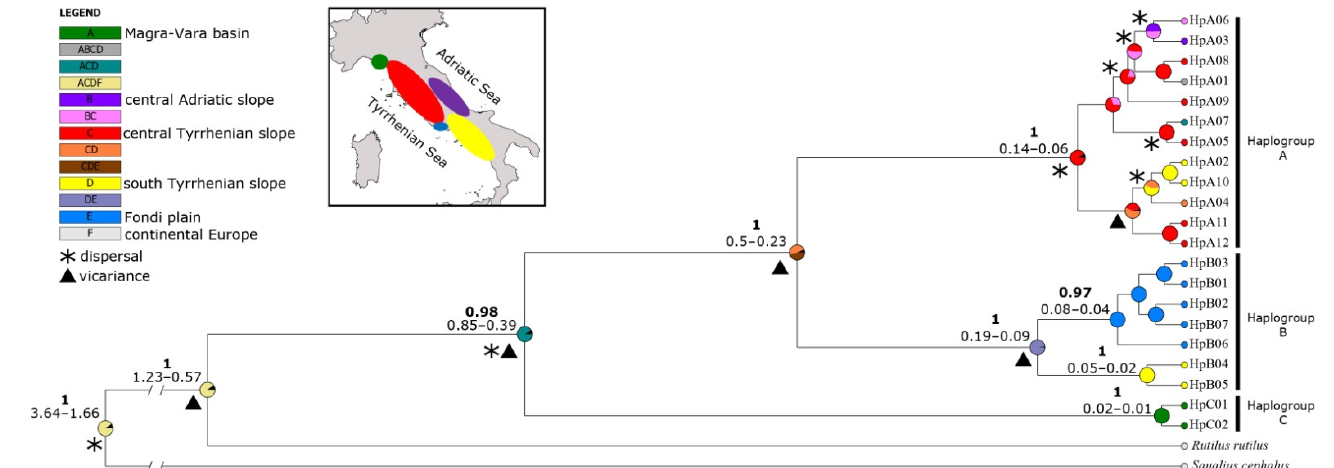
Figure 5. Bayesian CR tree with time estimates at supported nodes and ancestral area reconstruction of Sarmarutilus haplogroups and haplotypes. Posterior probability higher than 0.90 in bold; time estimates are in Mya; * denotes dispersal events, triangle vicariance events. Area reconstructions lower than 15% are indicated in black as null.